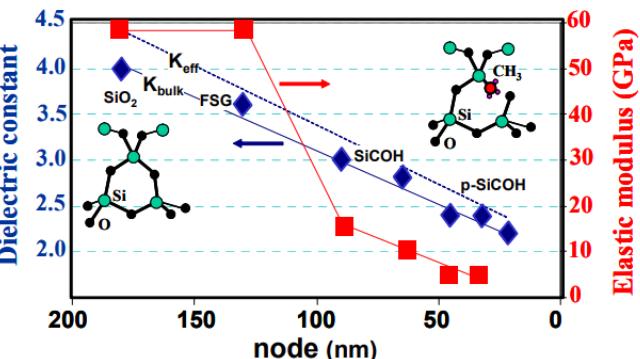
Figure 4. Relationship between the dielectric constant and the elastic modulus for different generation low-k materials. Reprinted/adapted with permission from Ref. [18]. 2009, IEEE.